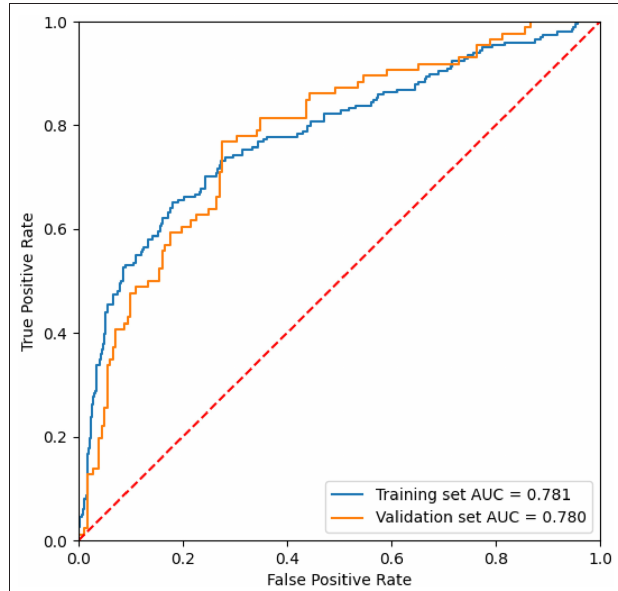
FIGURE 3 | Receiving operating characteristics (ROC) curves for the training set and validation set.